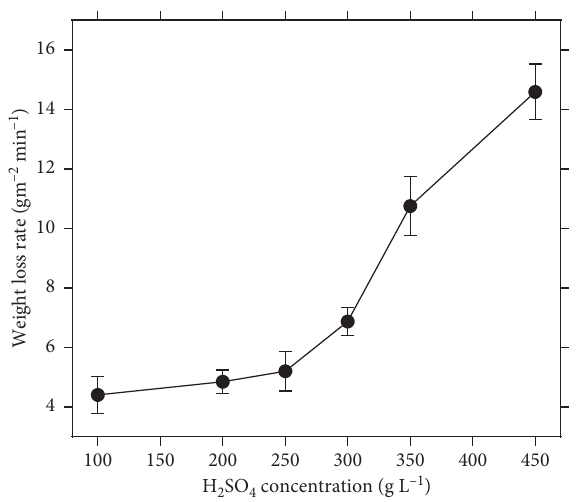
Figure 4: Variation of the static pickling rate in H different concentrations.